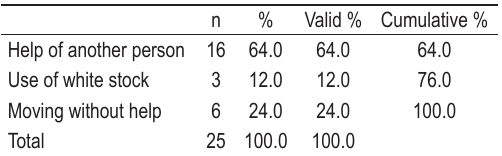
TABLE 3. Assistance at